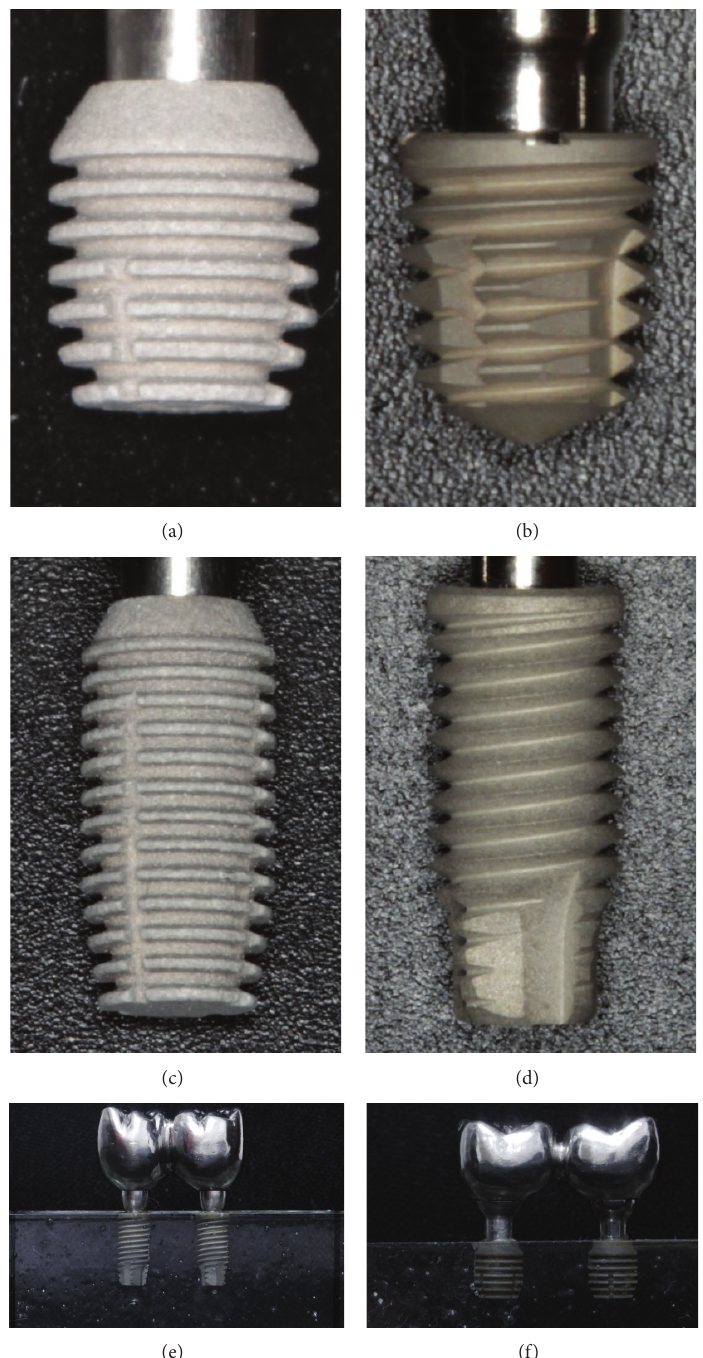
Figure 1: Implants and prosthetic crowns used in the study: (a) short implant (Bicon), (b) short implant (Neodent), (c) long implant (Bicon), (d) long implant (Neodent), (e) 2-unit implant-supported fixed partial prostheses of 8 mm prosthetic crowns, and (f) 2-unit implant- supported fixed partial prostheses of 13mm prosthetic